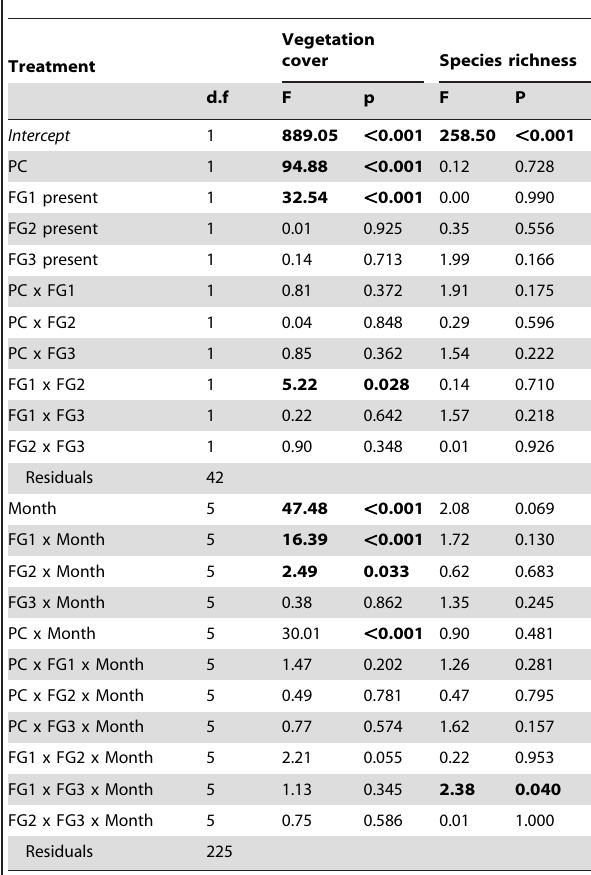
Table 3. Results of linear mixed effects models testing precipitation change (PC) and functional group (FG) treatment effects upon vegetation cover and species richness.